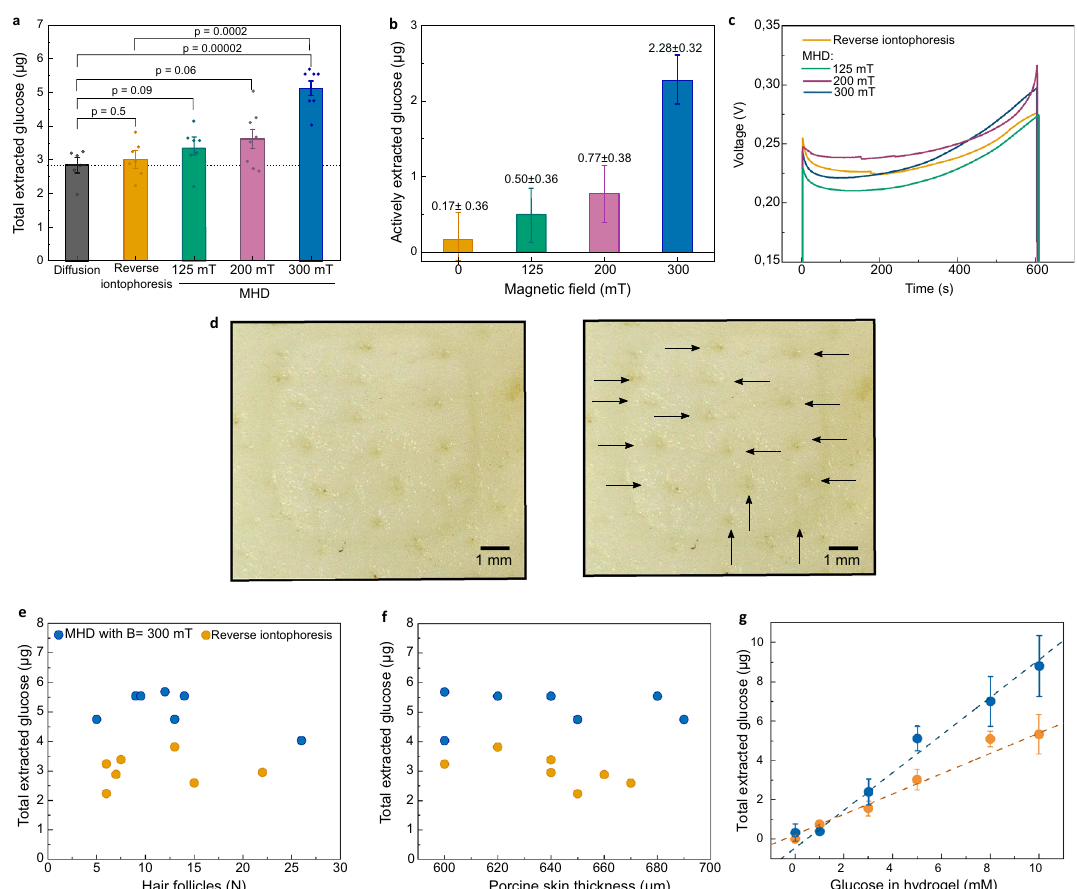
Figure 2. ( a ) Measured amount of glucose collected in the cathodic electrode well after 10 min extraction with passive diffusion, reverse iontophoresis, and MHD using 125 mT, 200 mT and 300 mT magnetic fields. Each extraction was done at room temperature (22 ± 1 °C) using GelMA hydrogel with 5 mM glucose, and an extraction current of 300 µA. P-values were calculated using an unpaired t-test. ( b ) The amount of actively extracted glucose was calculated by subtracting the contribution of passive glucose diffusion. ( c ) Measured voltage curves during extraction. Voltage between the extraction electrodes was measured during each extraction. ( d – f )Amount of extracted glucose in relation to the number of hair follicles and thickness of the skin samples. ( d ) Pictures from a porcine skin sample after extraction at the electrode well area, where the individual hair follicles are marked with arrows. ( e ) Number of hair follicles and total amount of glucose measured (extraction + diffusion) for both iontophoresis and MHD with 300 mT magnetic field. ( f ) Thickness of porcine skin and total amount of glucose measured (extraction + diffusion) for both iontophoresis and MHD with 300 mT magnetic field. ( g ) Total extracted glucose with different glucose concentrations in the GelMA hydrogel (p = 0.0002 from an F-test) (B = 300 mT, I = 300 µA). In figs ( a – c ) the bars show the average from at least 6 individual experiments and the error bars represent standard deviation of the